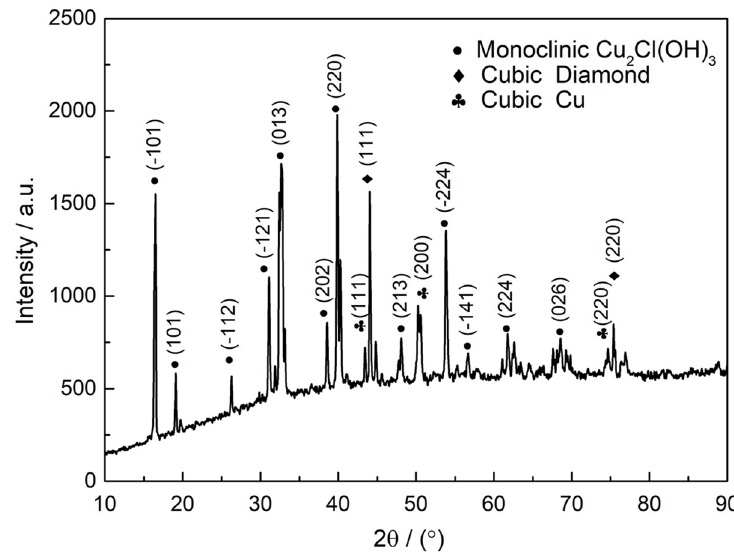
/ Cu composites corrosion Figure 9. XRD pattern of Diamond/Cu composites corrosion products. Figure 9. XRD pattern of Diamond